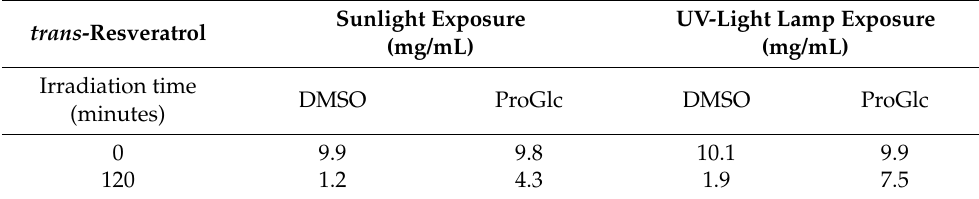
Table 1. trans -Resveratrol degradation after UV-light irradiation.